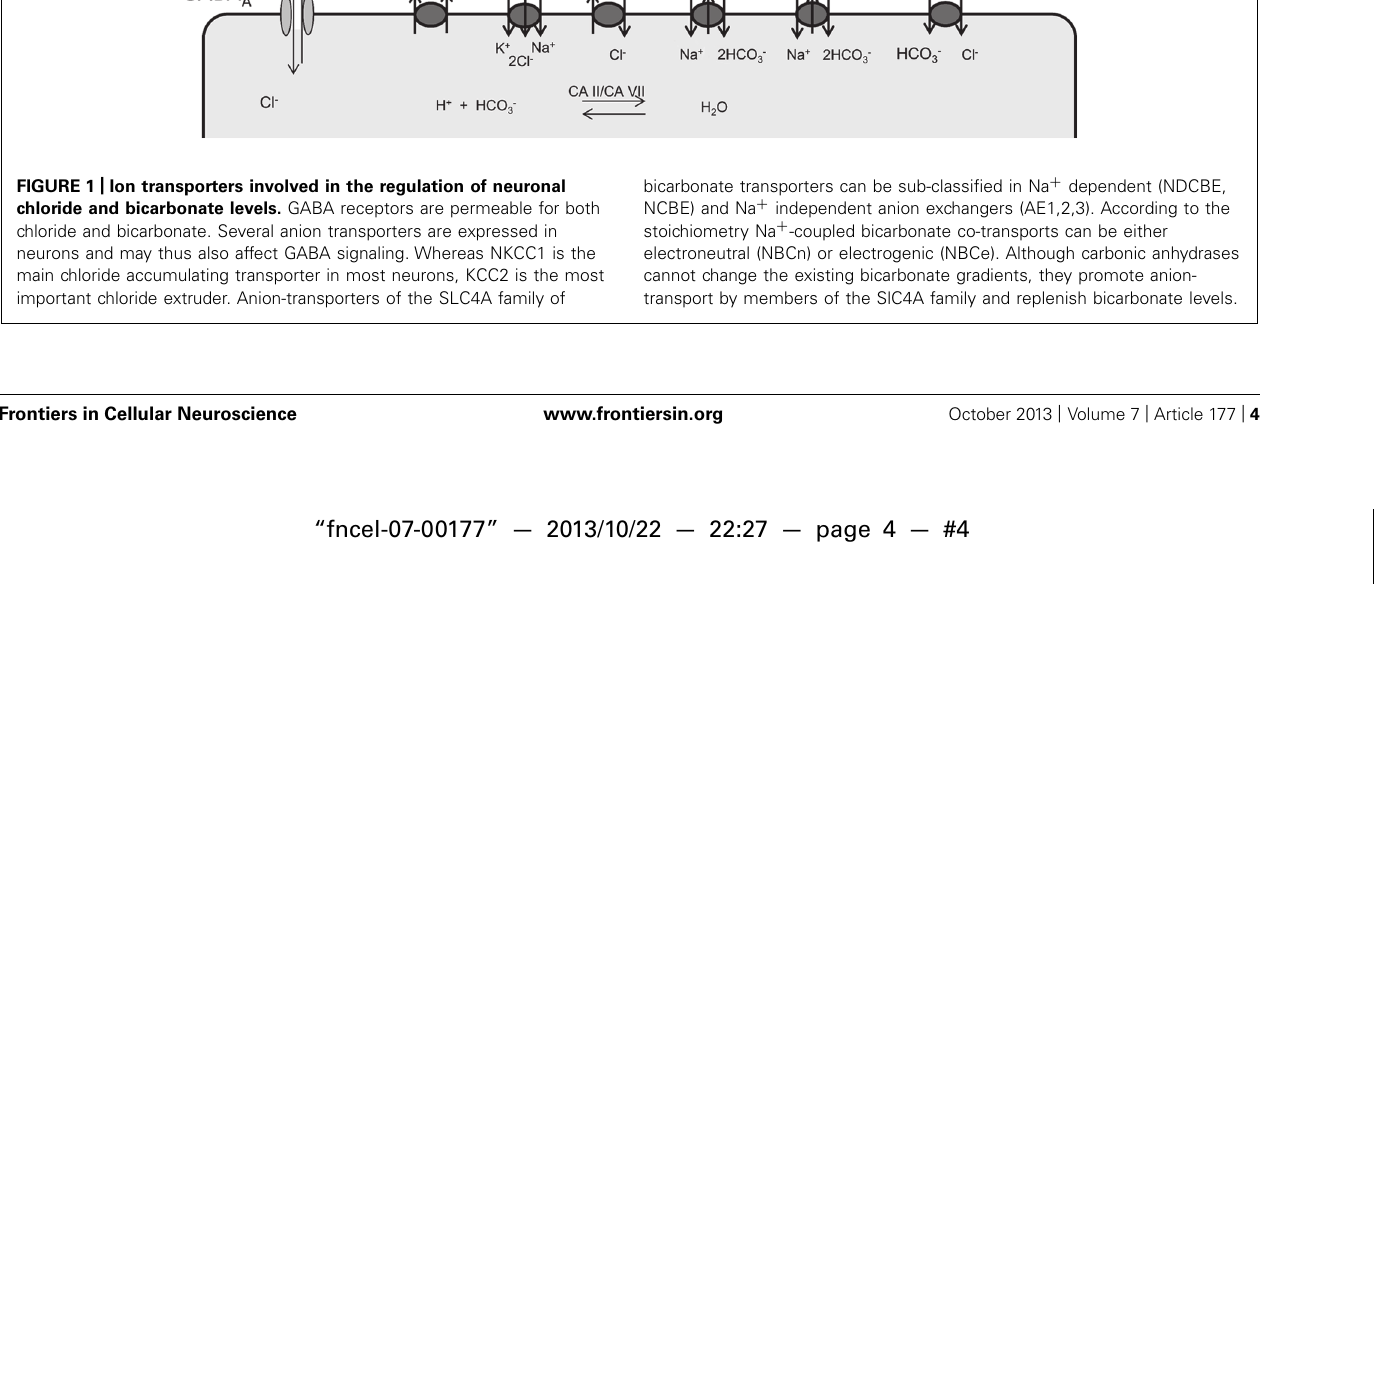
FIGURE 1 | Ion transporters involved in the regulation of neuronal chloride and bicarbonate levels. GABA receptors are permeable for both chloride and bicarbonate. Several anion transporters are expressed in neurons and may thus also affect GABA signaling. Whereas NKCC1 is the main chloride accumulating transporter in most neurons, KCC2 is the most important chloride extruder. Anion-transporters of the SLC4A family of